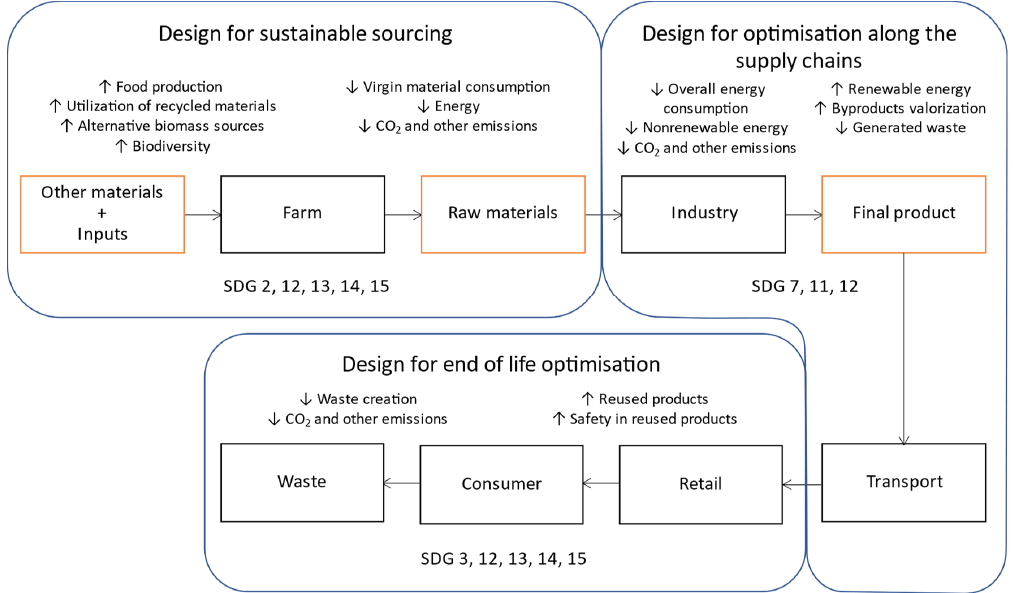
Figure 4. Potential implementation of the three main components of the ecodesign principles in a generic food chain—(1) design for Sustainable Sourcing, (2) design for optimised resource use and (3) design for end-of-life optimisation. This implementation is in line with relevant Sustainable Developing Goals (SDGs). Possible outcomes of implementing such concepts can be found